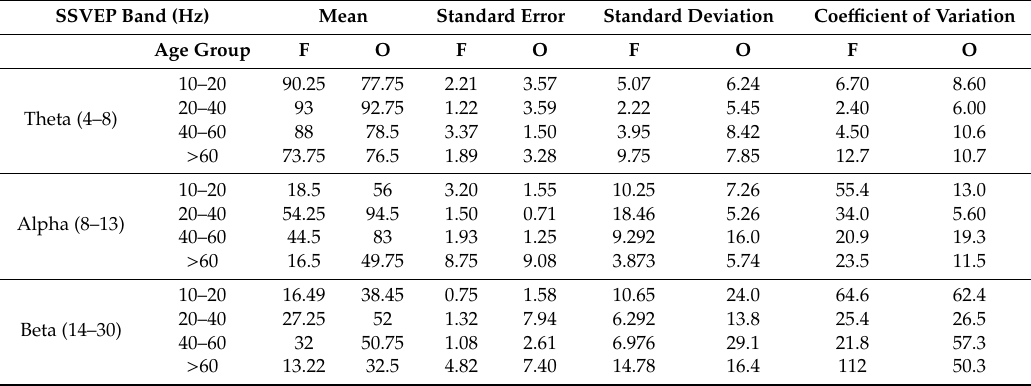
Table 1. Theta, alpha, and beta frequency detection accuracy in varying age groups and corresponding